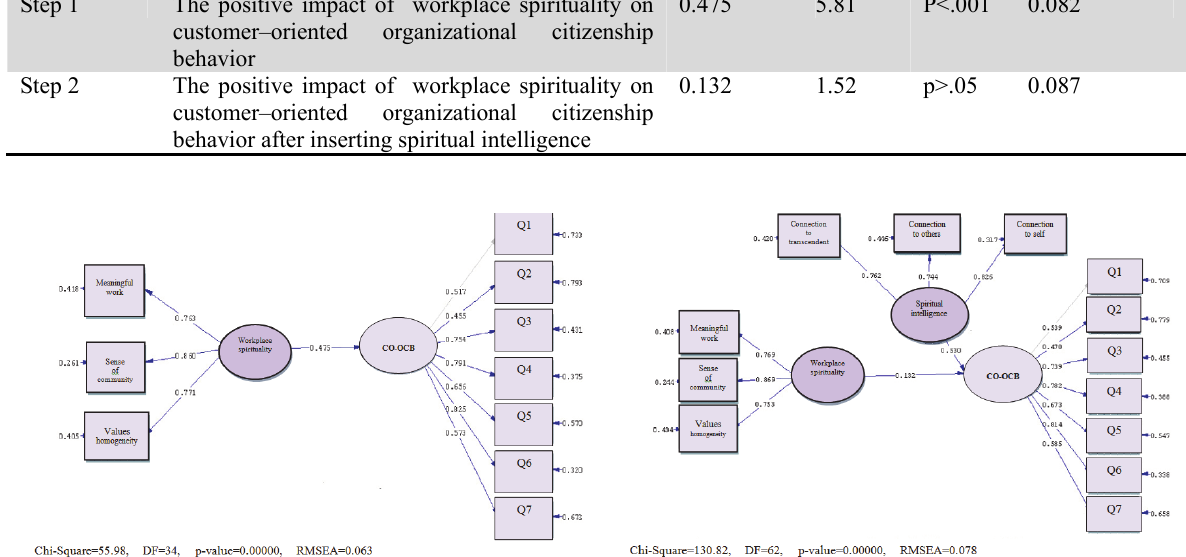
Fig. 6. the estimation model of the impact by “spirituality in work” on “customer–oriented organizational